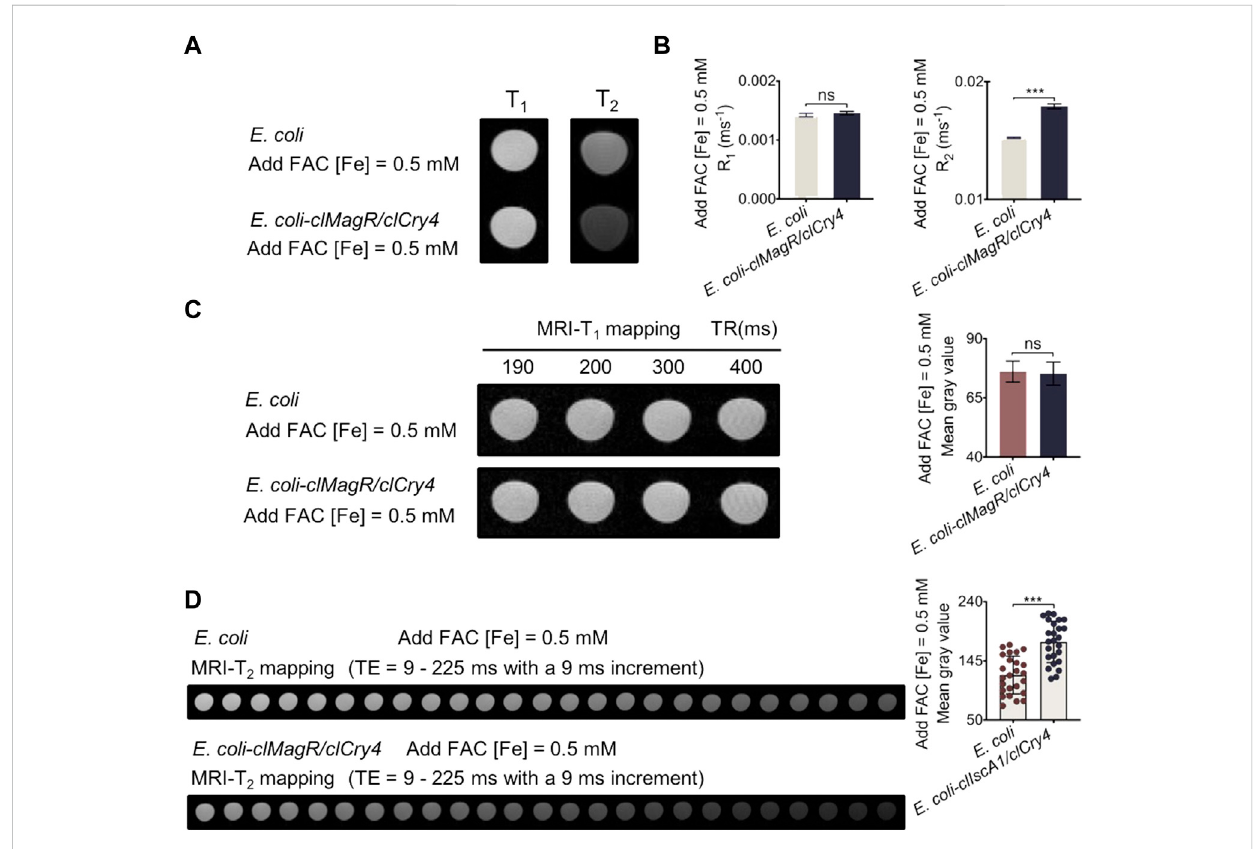
FIGURE 3 MRIanalysisofbacteriaunderexogenousironsupplyconditions. (A) MRI-T 1 and-T 2 imagesshowingsignalintensityofbacteria. (B) MRIstatisticalR 1 and R 2 values analysis of the bacteria. (C) Bacterial MRI-T 1 mapping and the corresponding mean gray values analysis. (D) Bacterial MRI-T 2 mapping and thecorrespondingmeangrayvaluesanalysis.Itshouldbenotedthatthebacterialdensitiesofsampleswerealmostequivalent(A600units/mL,OD50.0). Datawerepresented asmean±SD( n =3).ForMRIR 1 andR 2 values,statistical differences wereanalyzed usingtheunpaired Student ’ st-test.Forthe mean gray value data, statistical signi fi cances were analyzed using two-way ANOVA followed by Bonferroni and Tukey ’ s HSD post-hoc test. ns, no signi fi cance ( p > 0.05), *** p <